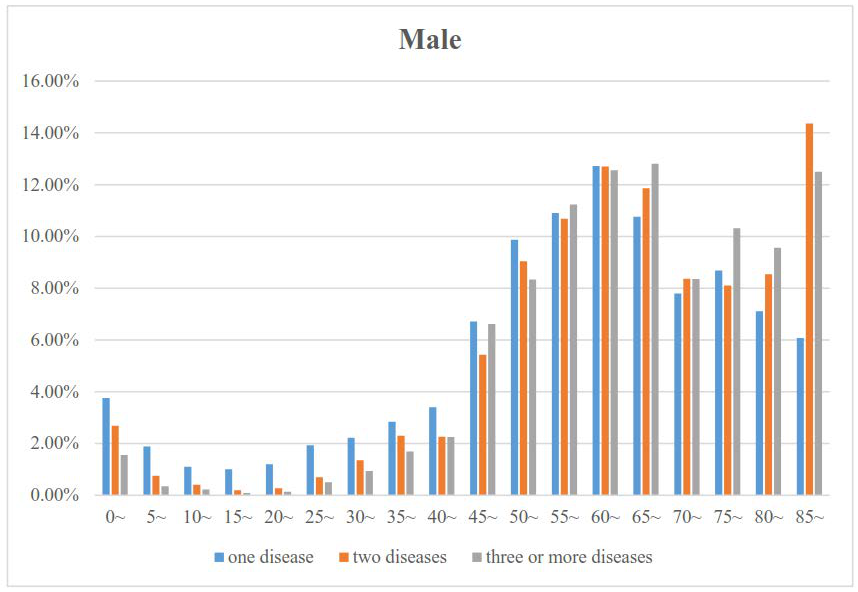
Figure 2. Association between age and the proportion of the number of diseases for male.